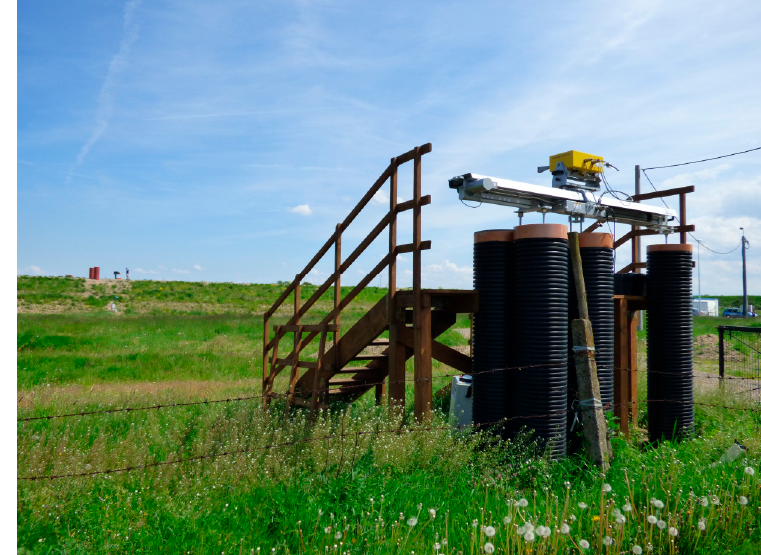
Figure 2. Experimental flood embankment as the subject of ground-based radar interferometry (GBSAR) observations.